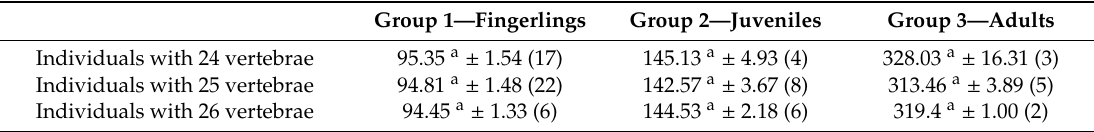
Table 1. Mean total length (mm) of European seabass individuals grouped by age and total number of vertebrae.